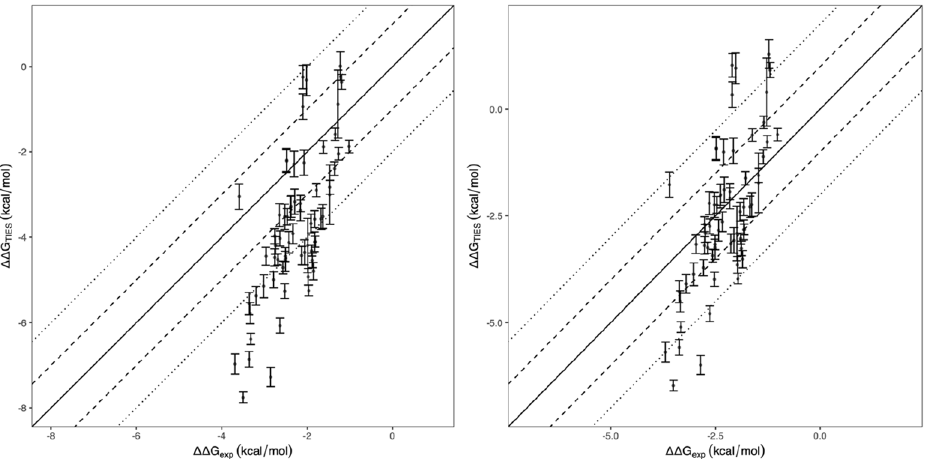
Figure 7. Original and “corrected” binding free energies from TIES calculations, compared with the experimental data. The correction is made by assuming a systematic overestimation is introduced by –CH to –C–CH–(CH 3 ) 2 transformation which is involved in all of these